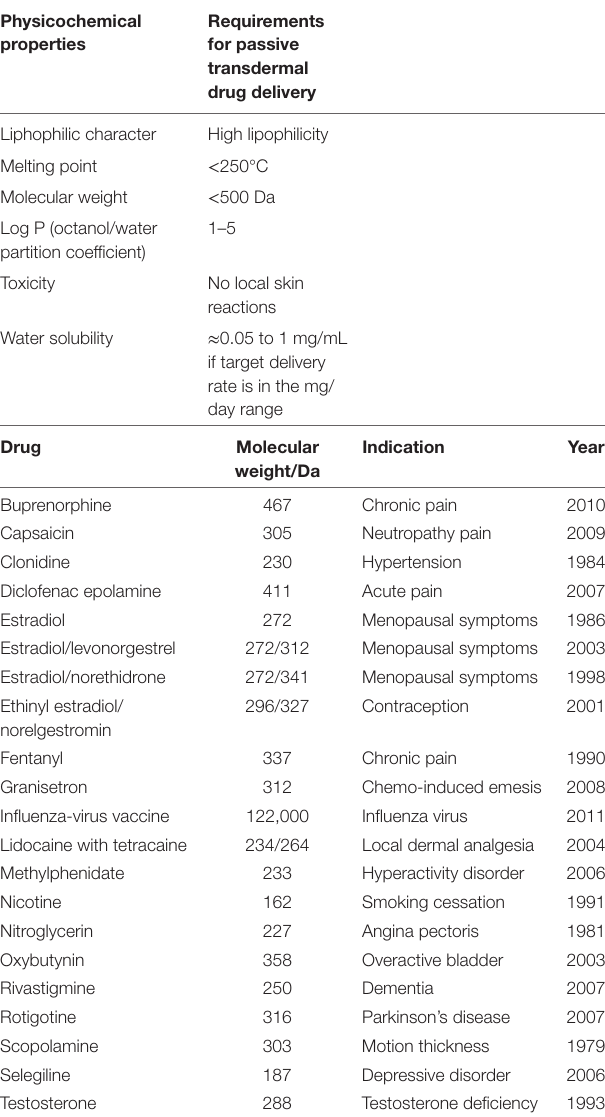
TAble 1 | Required physicochemical properties for a passive transdermal drug delivery and FDA-approved transdermal delivery systems. Physicochemical